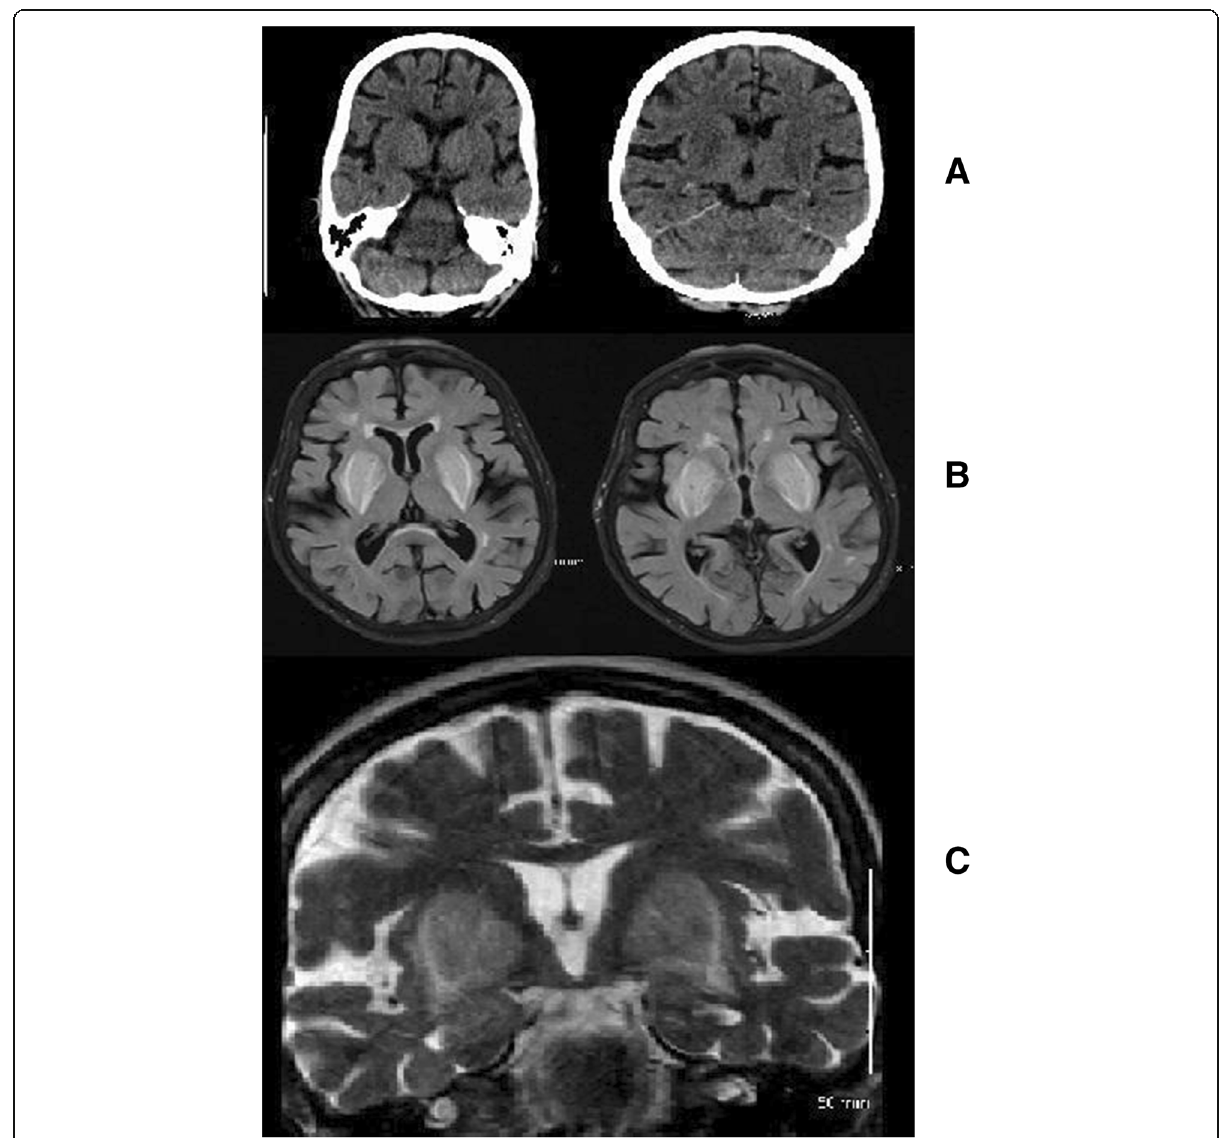
Fig. 1 Showing CT Scan and MRI Brain images. a C T-brain showing bilateral symmetrical hypodensity in the basal ganglia. b MRI Brain axial FLAIR sequence. c MRI brain coronal T2 sequences both showing bilateral symmetrical swollen lentiform nuclei with a hyperintense T2/FLAIR signal rim delineating the boundaries of the